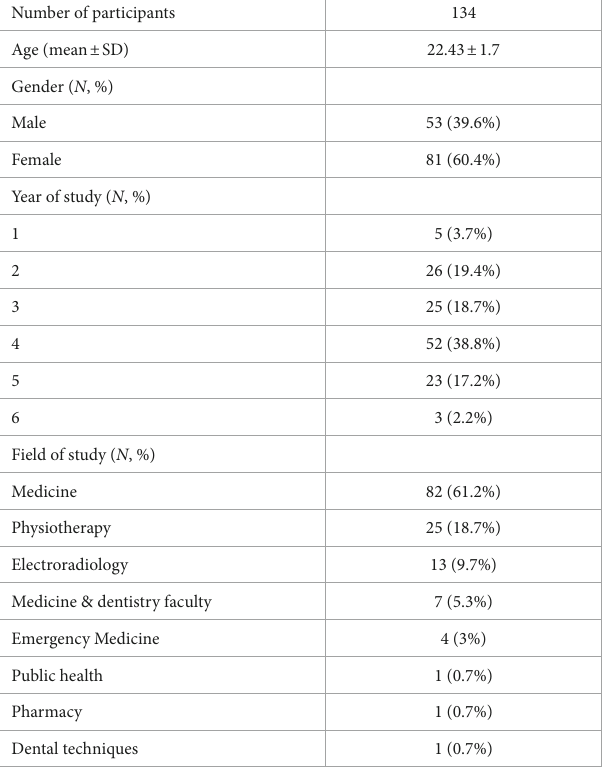
TABLE 1 Socio-demographic characteristics of the sample ( N = 134).